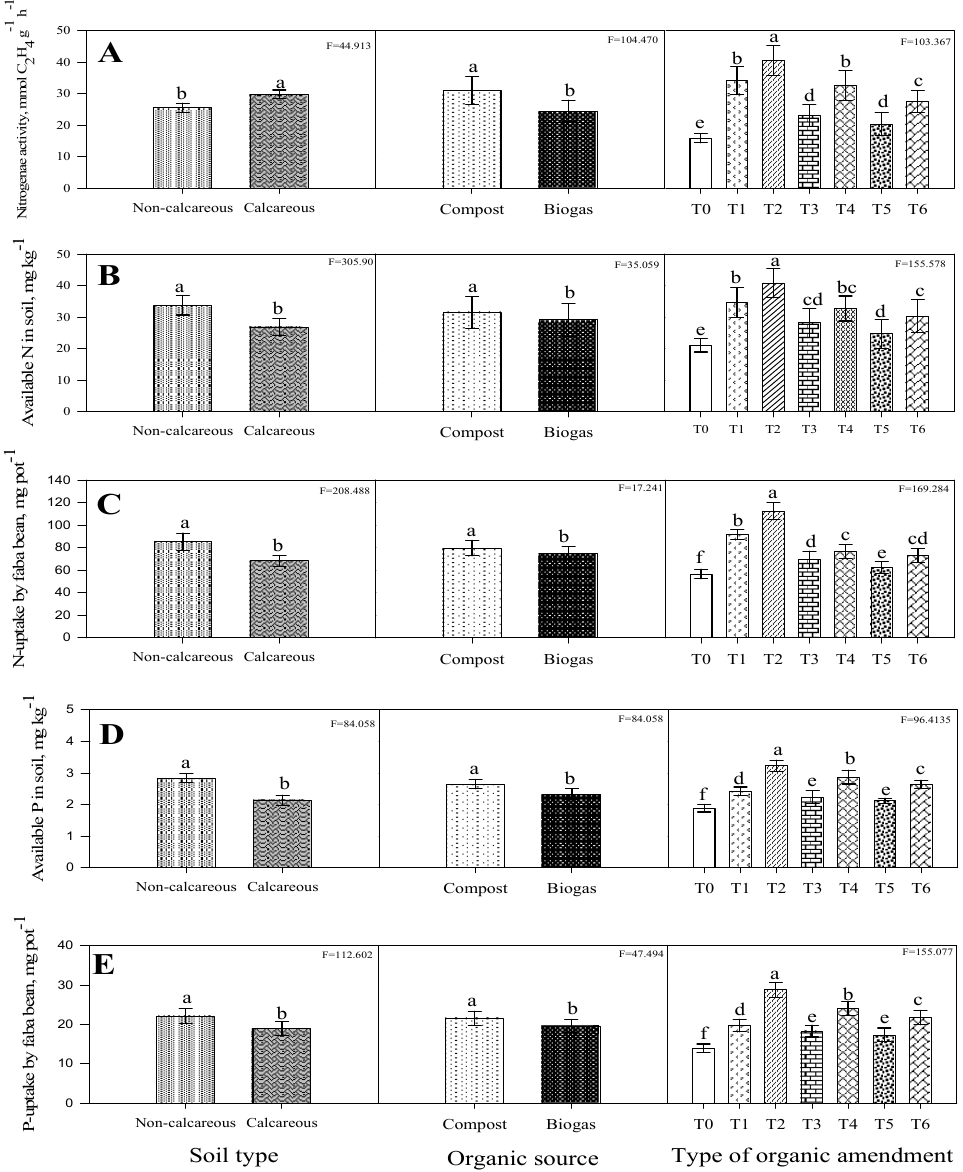
Figure 1. Grand means of nitrogenase enzyme activity in plant rhizosphere ( A ), available N in soil ( B ), N-uptake by faba bean ( C ), available P in soil ( D ) and P-uptake by faba bean ( E ) in light-textured soils as affected by application of organic and mineral N-fertilizers, either solely or in different combinations. Treatments from T 0 to T 6 : no organic additions (T 0 ), 50% org (T 1 ), 100% org-N (T 2 ), 5 mL HA kg − 1 (T 3 ), 10 mL HA kg − 1 (T 4 ), 5 mL FA kg − 1 (T 5 ), 10 mL FA kg − 1 (T 6 ). Different letters indicate significant variations among treatments.